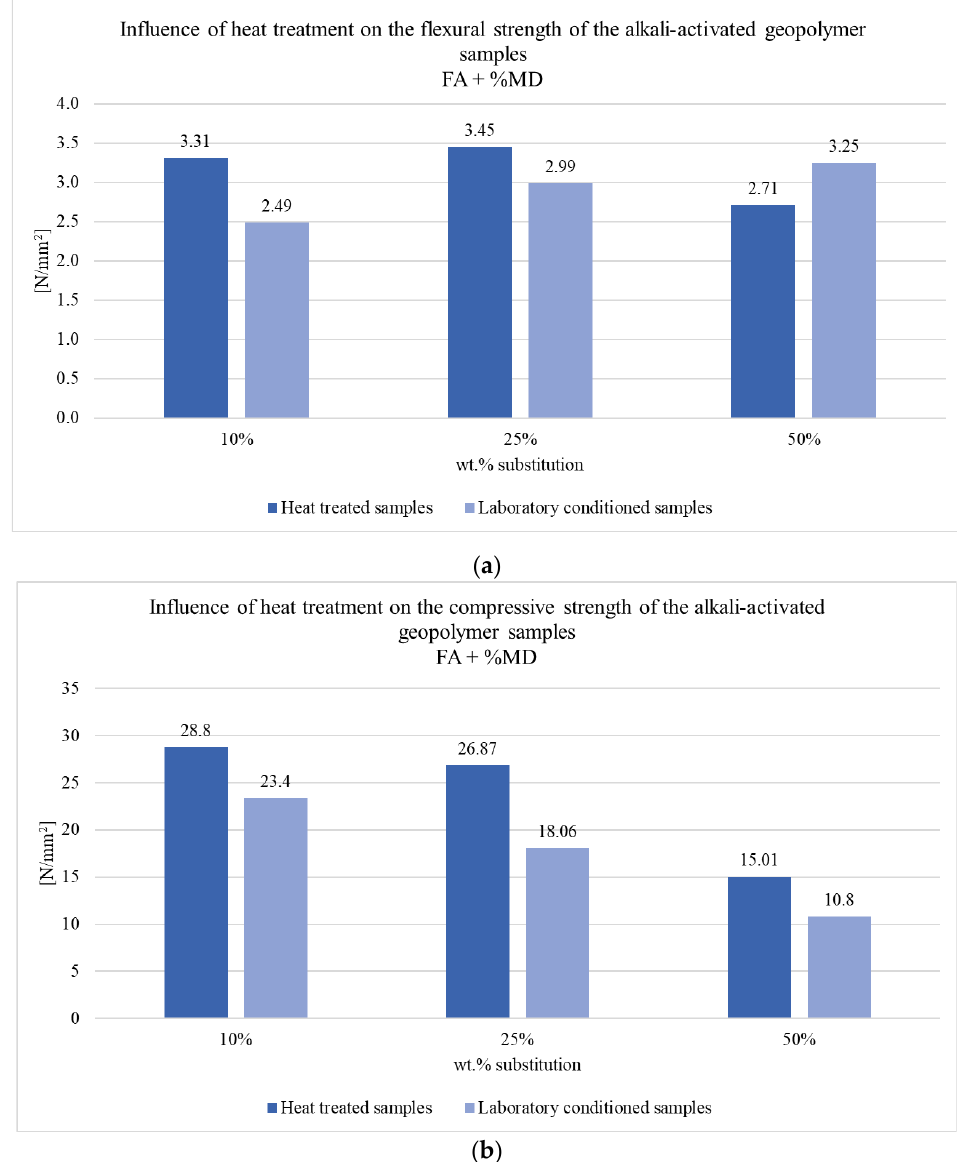
Figure 5. Influence of heat treatment on the mechanical properties of alkali activated geopolymer samples produces using marble dust as fly ash substitution: ( a ) Flexural strength and ( b ) Compressive strength.